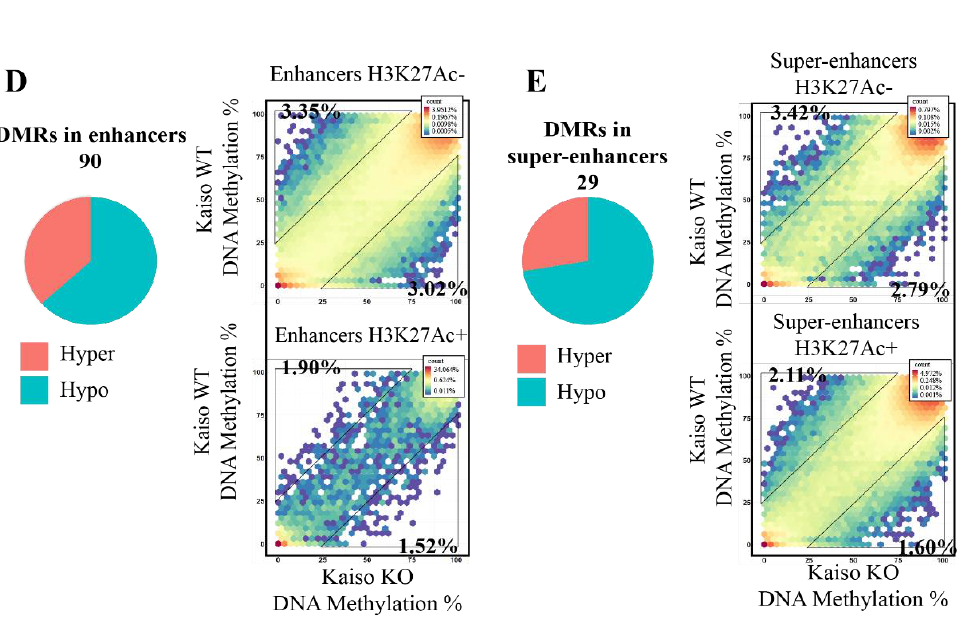
Figure 2. DMRs are associated with promoters and enhancers. Relative quantities of hyper- and hypo-DMRs that overlap with promoters ( A ), enhancers ( D ), and super-enhancers ( E ). ( B ) The relation between fold change of gene expression and the changes in DNA methylation within DMR in promoter regions. Hexagon plot showing methylation level for CpGs: ( C ) in all promoters ( n = 1,514,345), in upregulated in Kaiso KO cells ( n = 505,656), in downregulated in Kaiso KO cells ( n = 32,328); ( D ) in enhancers ( n = 254,090) with ( n = 10,551) or without H3K27ac ( n = 243,539); ( E ) in super-enhancers ( n = 213,561) with ( n = 162,969) or without H3K27ac ( n =